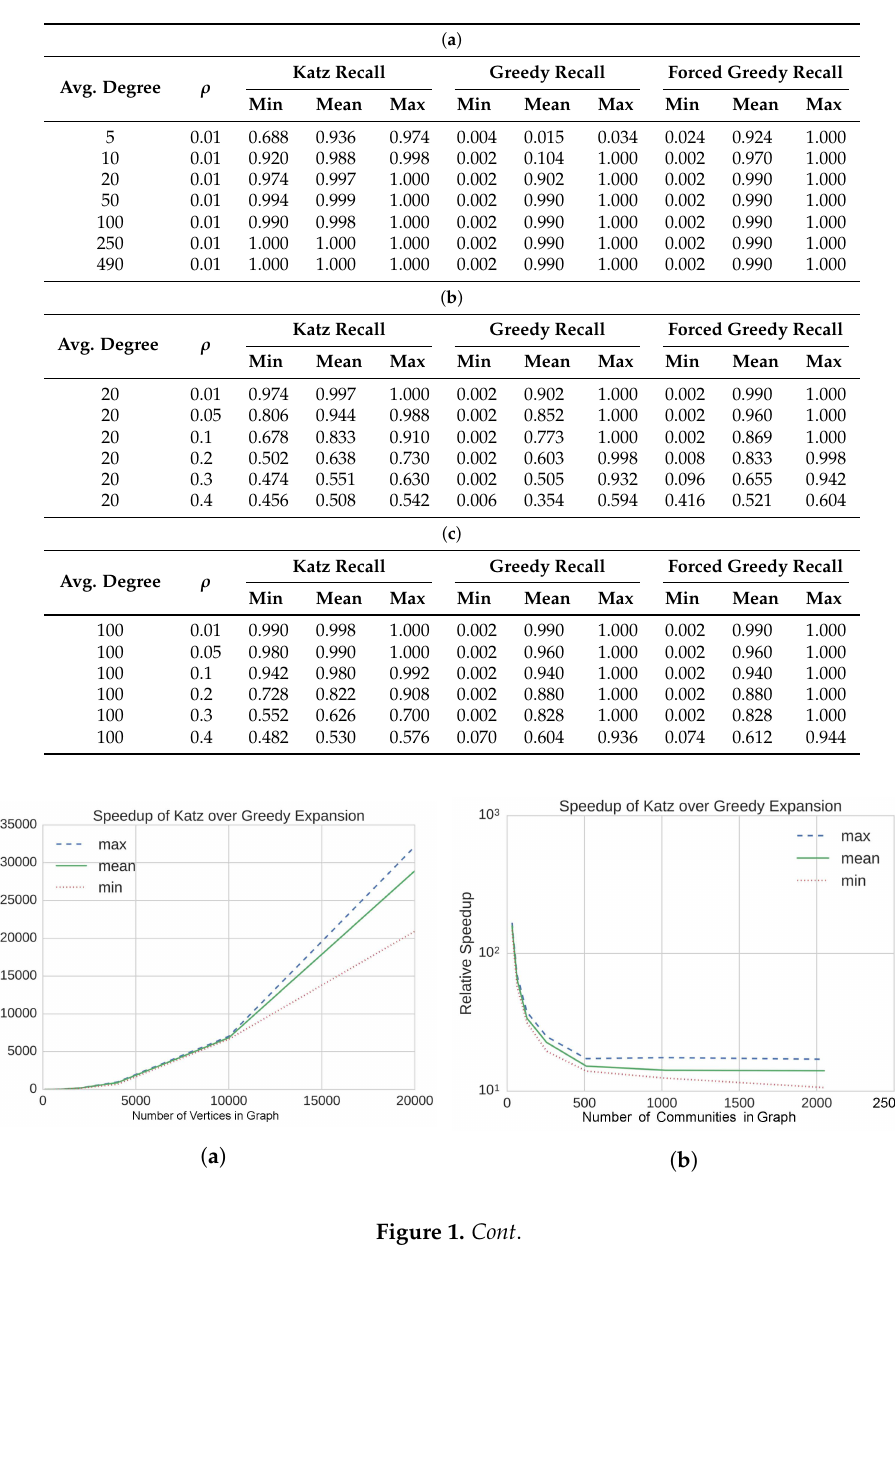
Table 2. The quality of communities detected with our personalized Katz method and greedy expansion is shown. Test graphs are stochastic block model (SBM) graphs with n = 1000 and k = 2. (a) The average vertex degree d is varied, while ρ = 0.01. (b) The proportion of inter-community edges ρ is varied, while d = 20. (c) The proportion of inter-community edges ρ is varied, while d = 100.